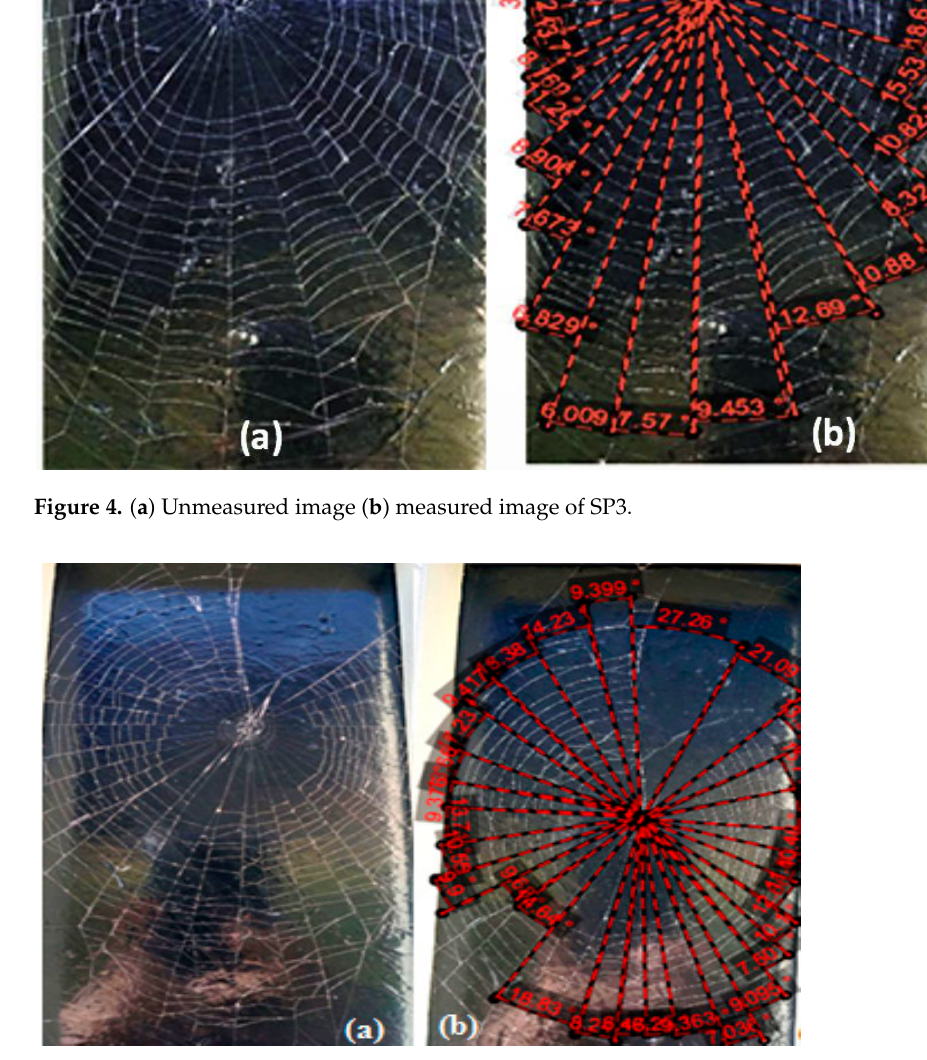
Figure 3. ( a ) Unmeasured image ( b ) measured image of SP2.